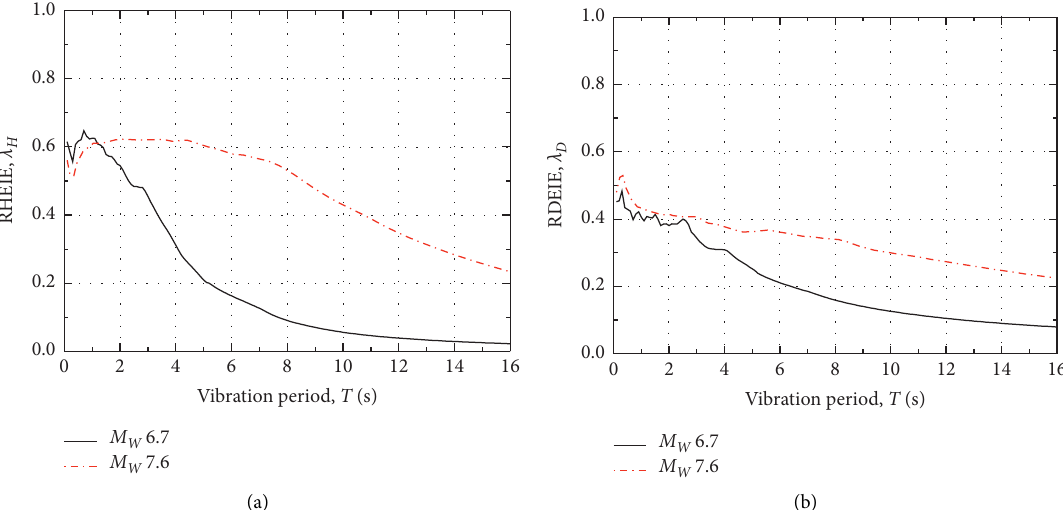
Figure 9: Energy distribution rule affected by earthquake magnitude under near-fault pulse-like ground motions. (a) RHEIE. (b)